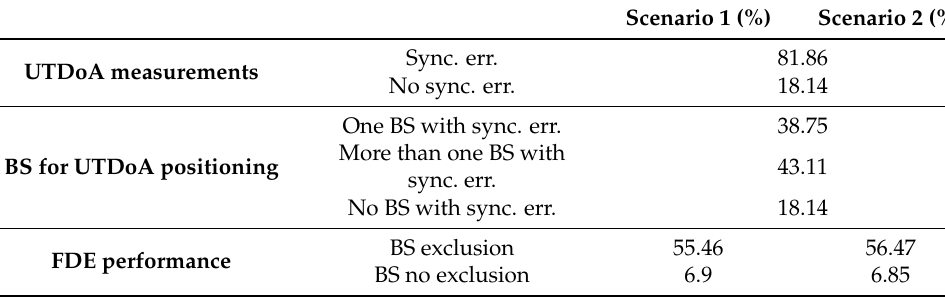
Figure 8. Results for 50 MHz bandwidth with perfect sync. Table 2. Performance of BS exclusion mechanism in positioning